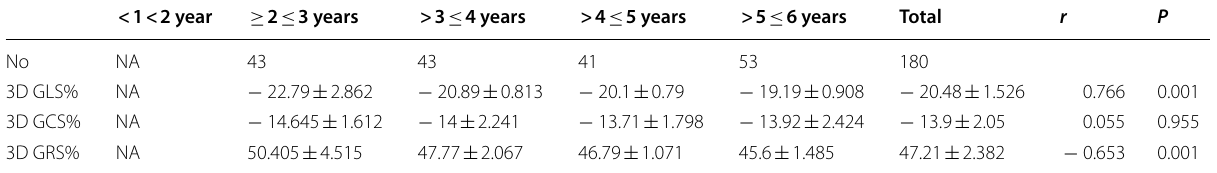
Table 4 Mean of 3D speckle tracking parameter in subjects of our study categorized according to age-group and r and P values of correlation between 3D strain and age